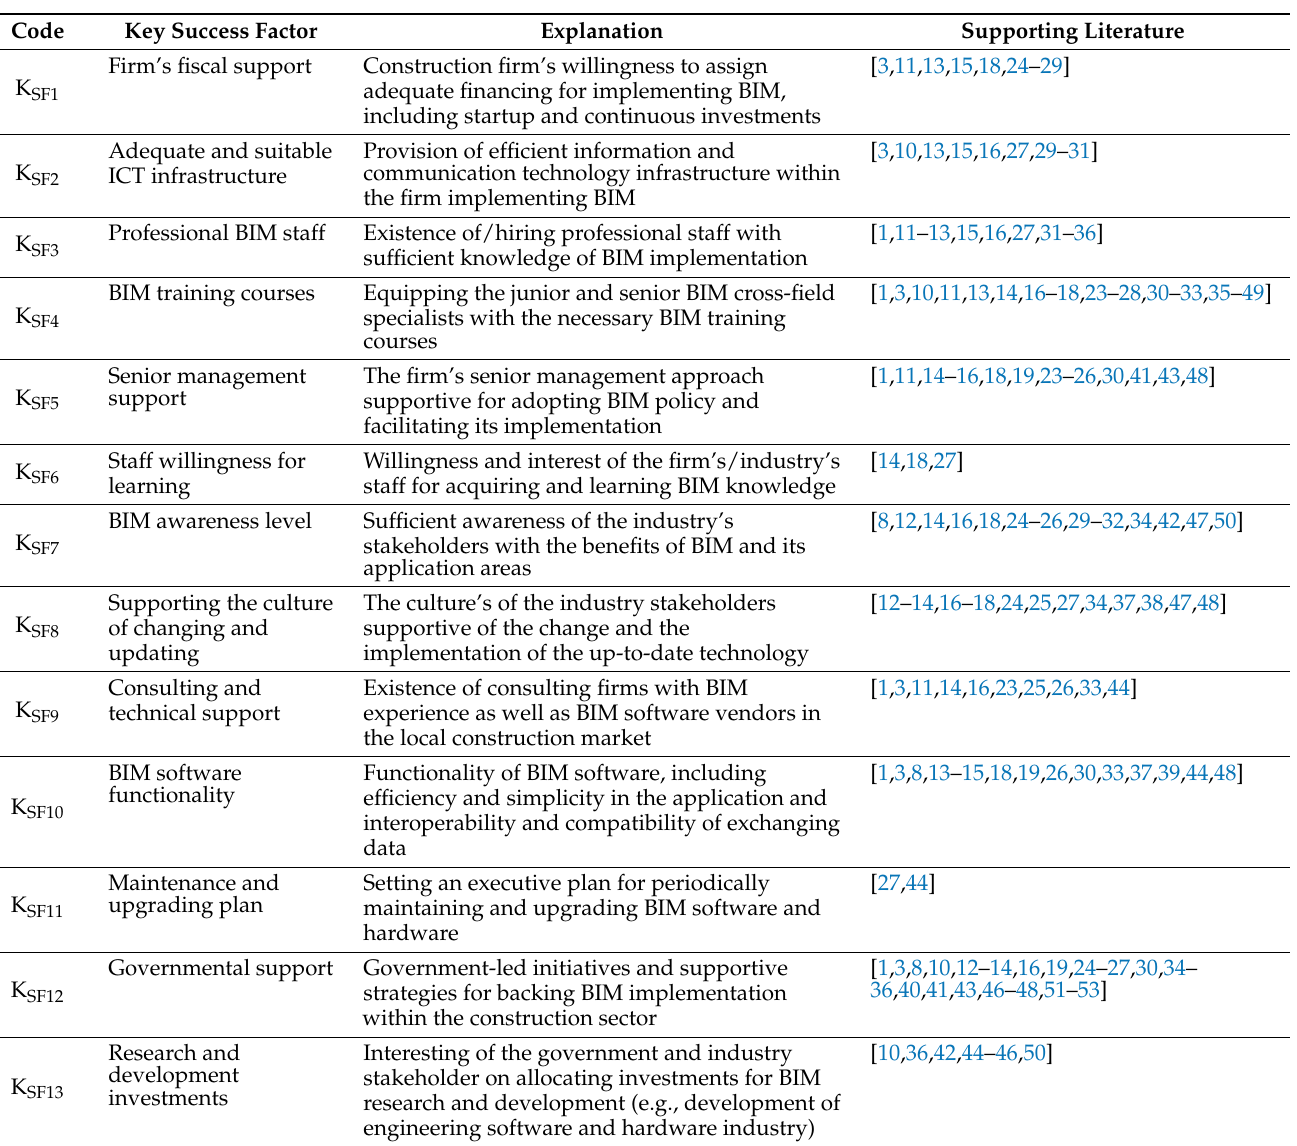
Table 1. BIM implementation key success